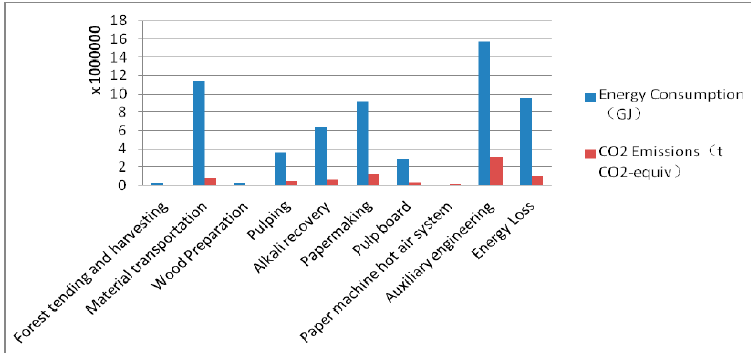
Figure 11. Energy consumption and embodied carbon emissions from major production processes.